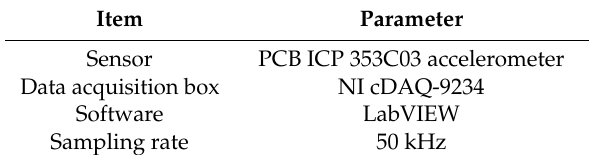
Table 1. Data acquisition settings.